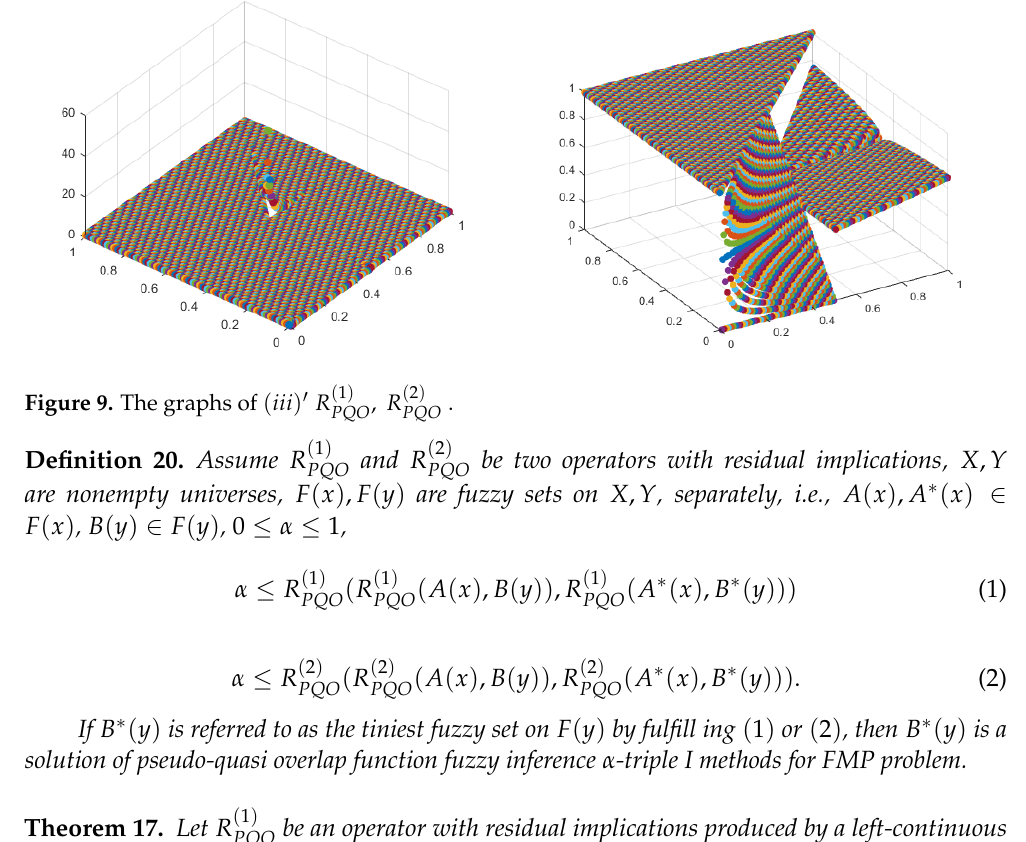
Figure 9. The graphs of ( iii ) (cid:48) R